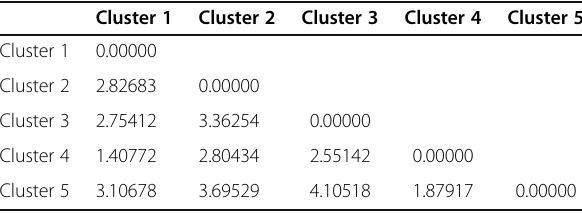
Table 14 Distances between clusters centroids – Optimized